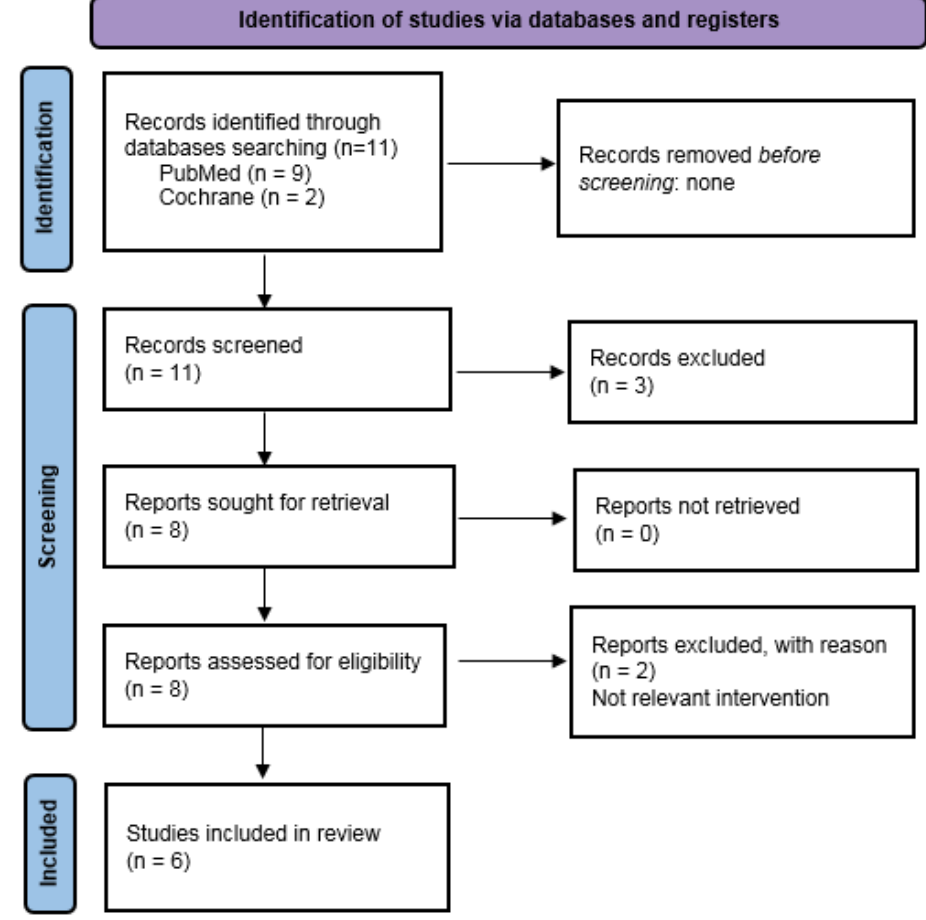
Figure 2. PRISMA 2009 flow diagram with the research strategy.